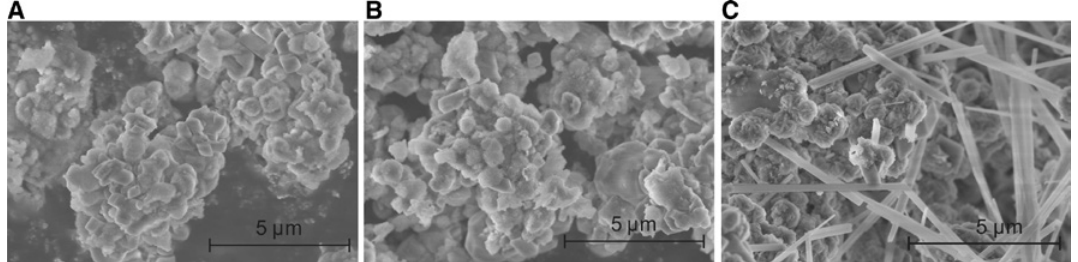
Figure 9: Scanning electron microscopy images of different carbonated residues. Morphologies produced by (A) the discrete process, (B) the direct process, and (C) the whole process using 40 g/l